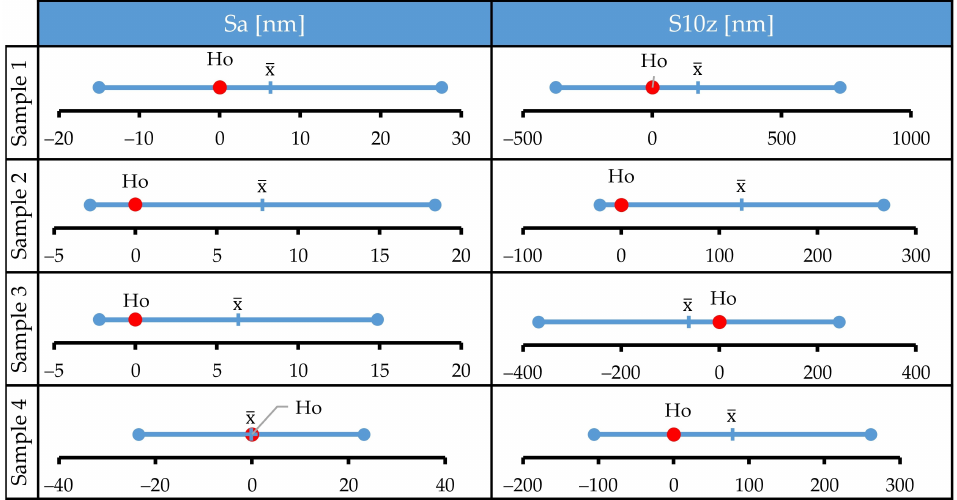
Figure 3Figure 3. Results of a paired t test: statistical analysis of the changes in Sa and S10z parameters determined on areas of 80 × 80 µ m before and after the corrosion